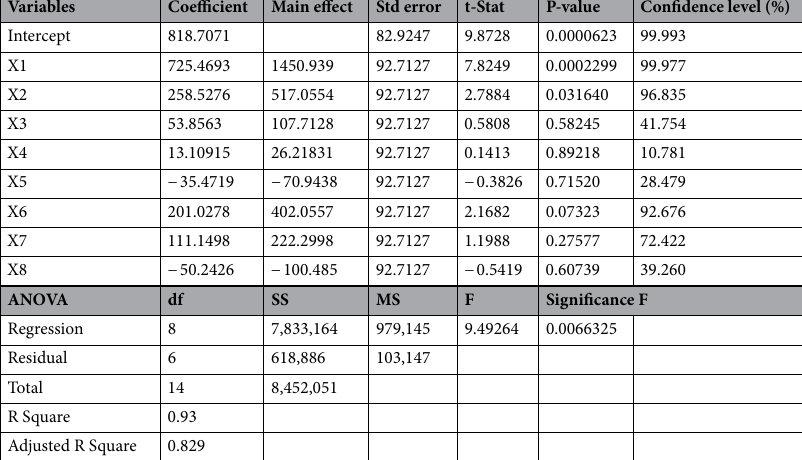
Table 2. Statistical analysis of PBD showing coefficients and t- and p-values for each variable affecting ALP